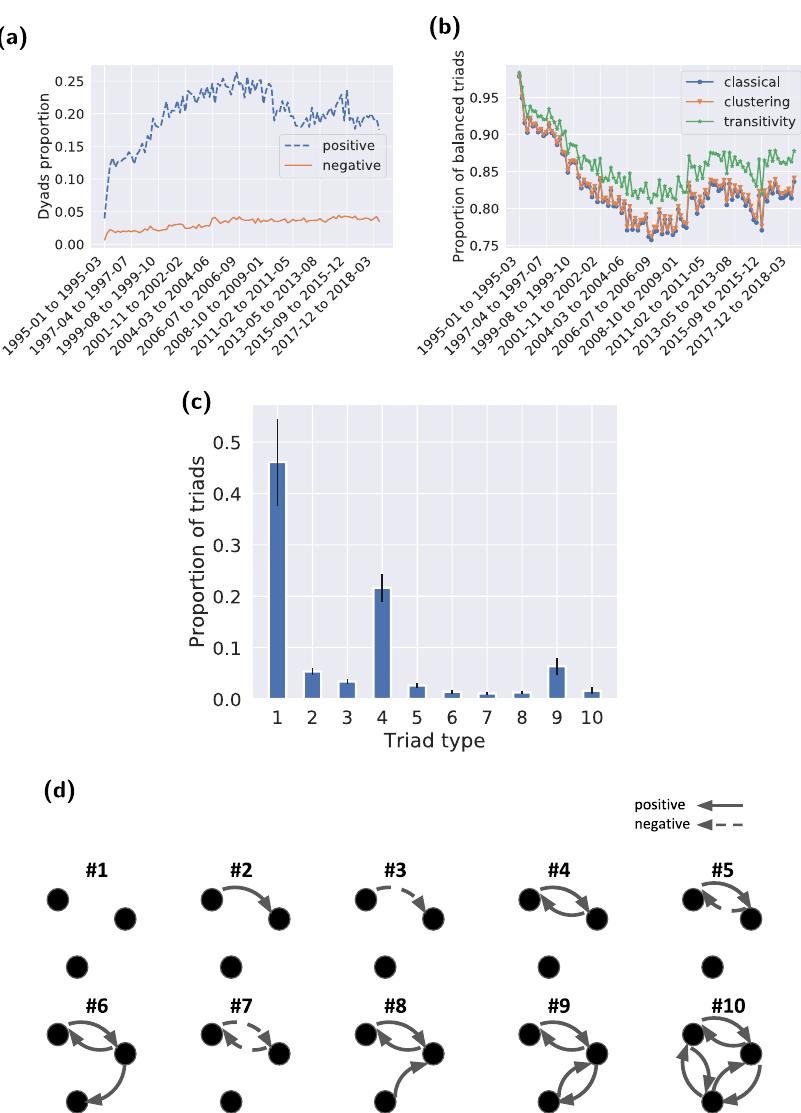
Fig. 1 Network dyads and triads over time. This fi gure presents the dynamics of Integrated Crisis Early Warning System (ICEWS) network over time. a Proportion of positive and negative dyads (edges) over time in the strongly connected component. b Proportion of balanced triads over 23 + years. The three lines represent different subsets of Heider axioms as structural balance criteria in which they all show a similar trend. Triads are counted in networks built by aggregating 3 months of news articles. We found that changing the period length to monthly, biweekly, and weekly does not change the trend in this fi gure. c Average proportion of triads over 23 + years. Error bars correspond to one standard deviation and are computed using n = 103 network snapshots of quarters. d The set of ten operative triads (most frequent triads out of 138 possible